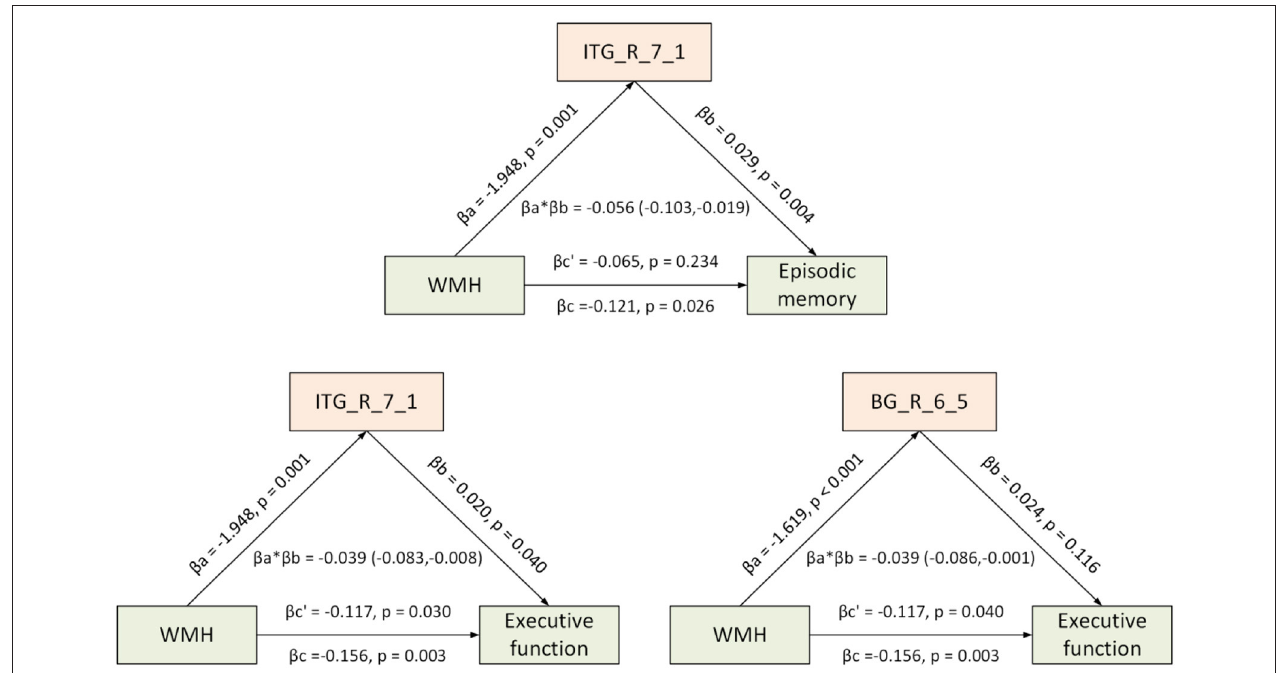
FIGURE 5 | Mediation effect of regional CBF between WMH load and cognitive function. Diagrams show areas of CBF mediating relationship between WMH load (represented as Fazekas score) and cognitive performance (executive function or episodic memory), and mediation models of pathways from WMH load to CBF reduction in right ITG and right caudate to reduce cognitive performance. In each model, age, sex, and years of education were entered as covariates. β a and β b represent coefficients of relationships between WMH load and regional CBF, and associations between region CBF and cognition (when both WMH load and CBF were both entered into model as predicting variables). Total effect ( β c) = Direct effect ( β c’) + Mediation effect ( β a* β b). Mediating role of regional CBF reduction on association between WMH and cognition is defined when 95% confidence interval did not conclude 0 for 5,000 bootstrapping iterations. BG, basal ganglia; CBF, cerebral blood flow; FCS, functional connectivity strength; ITG, inferior temporal gyrus; WMH, white matter hyperintensities. L, left; R, right. Detailed information on brain regions is available at